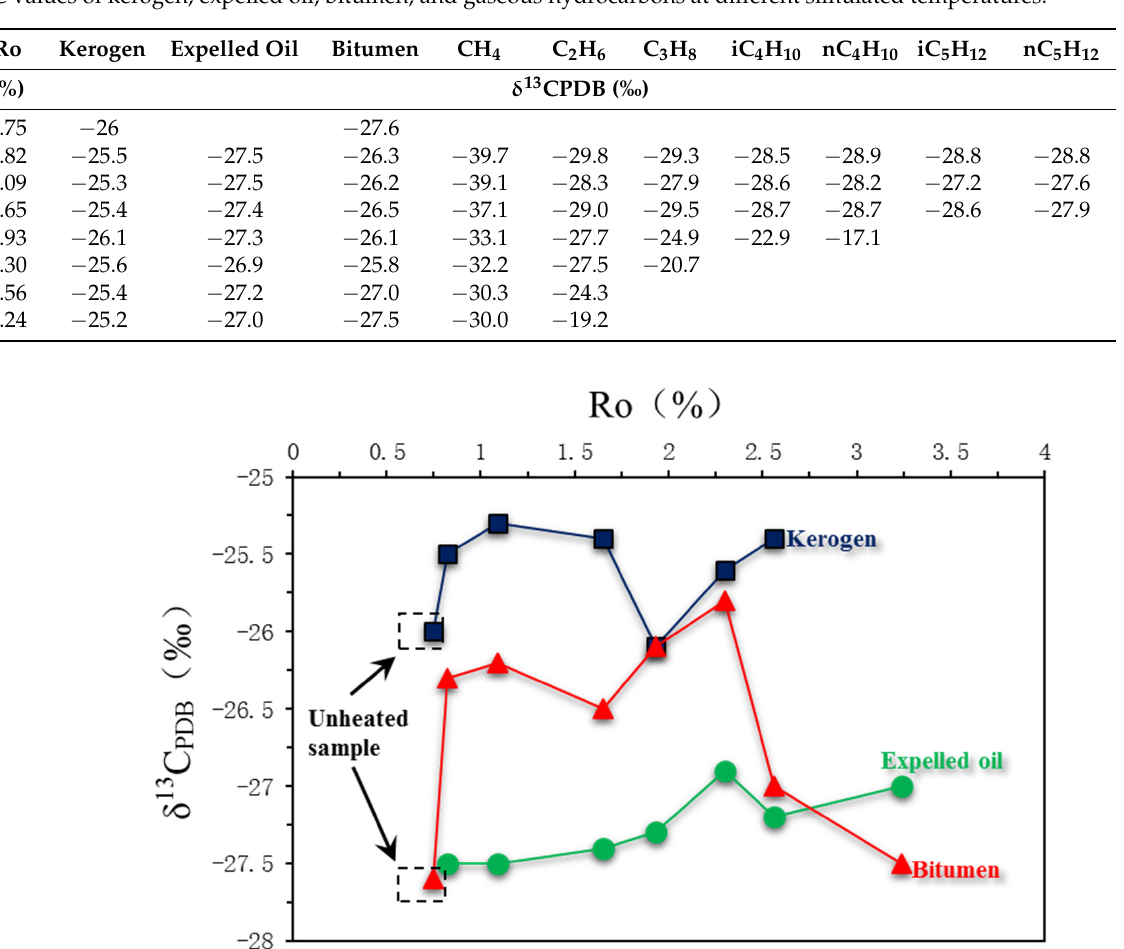
Figure 5. δ 13 C values of kerogen, expelled oil, bitumen, and gaseous hydrocarbons at different Ro. The δ 13 C values of kerogen and bitumen in the original sample (Ro equals 0.75%) were − 26‰ and − 27.6‰, respectively. With an increase in Ro, the δ 13 C values of